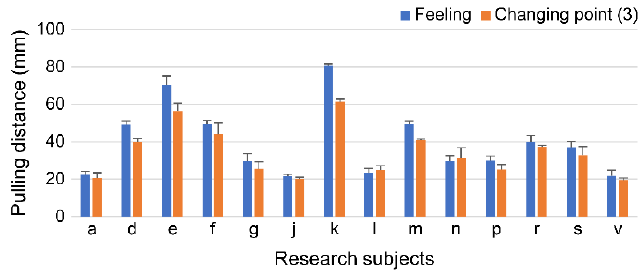
Figure 10. Sensations and points of change when you finish feeling comfortable.